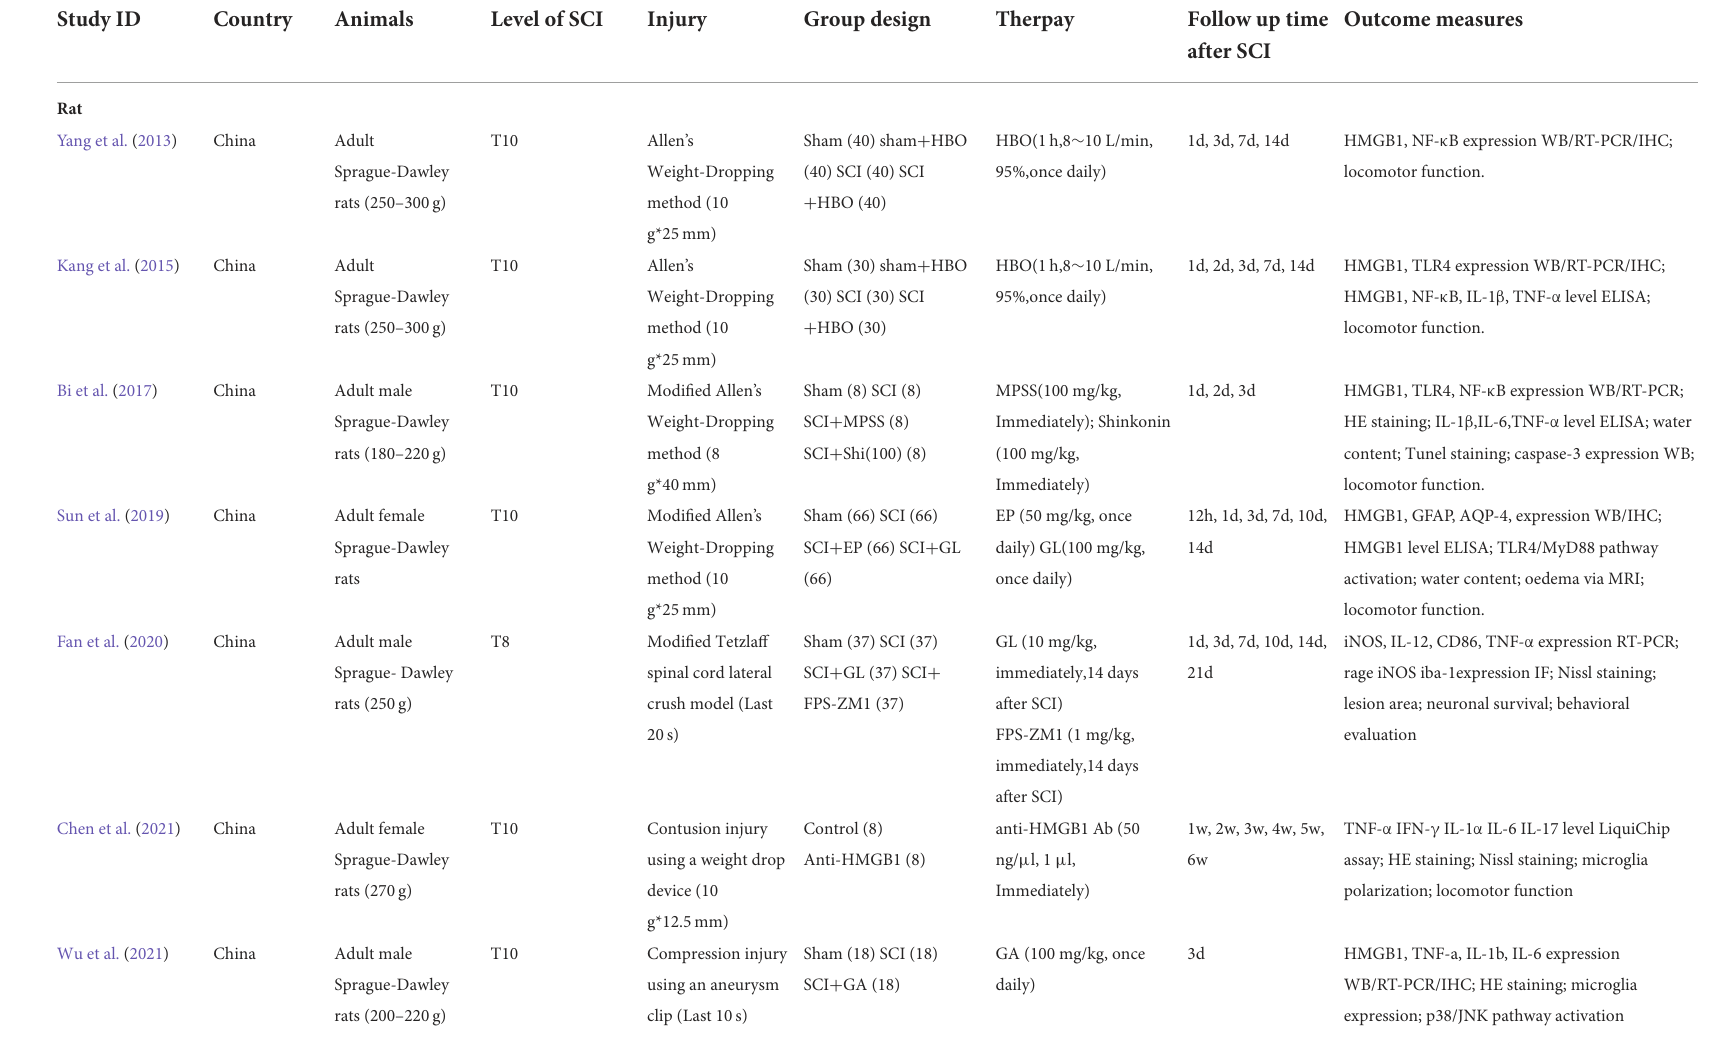
TABLE 1 Characteristics of the included